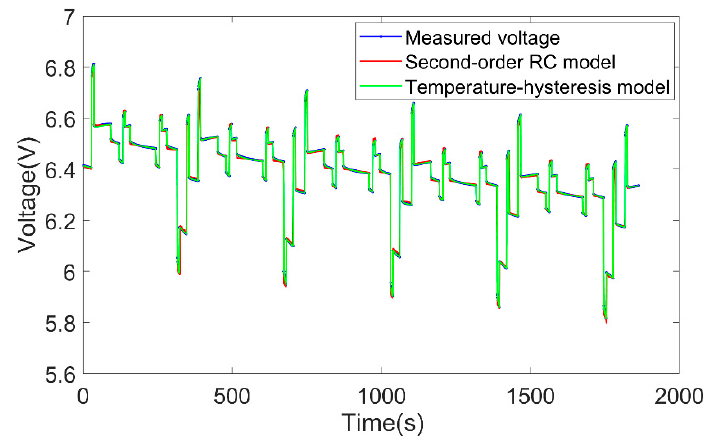
Figure 13. Battery models output and measured voltage at 25 °C .